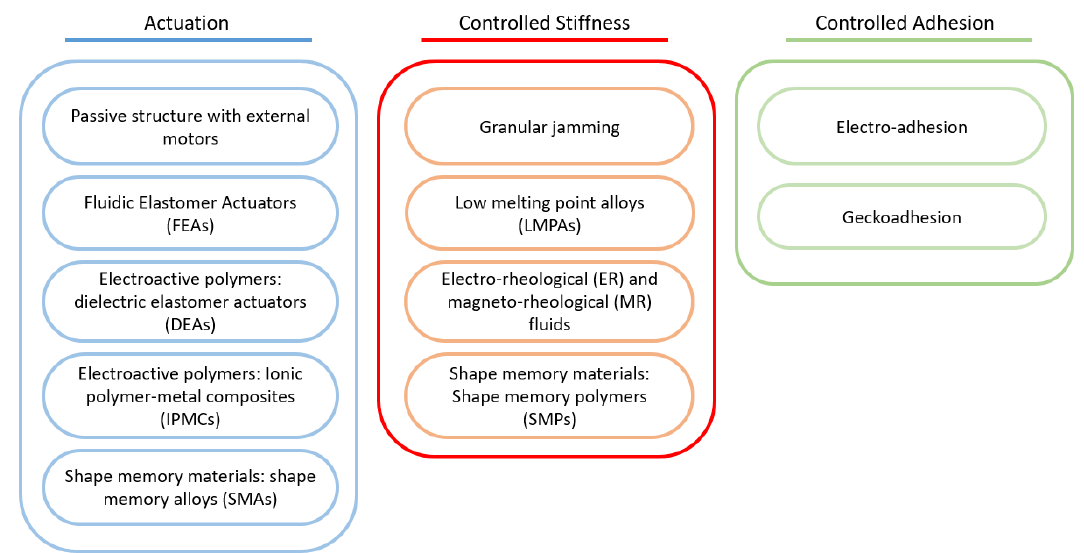
Figure 4. Classification of soft gripping technologies proposed by